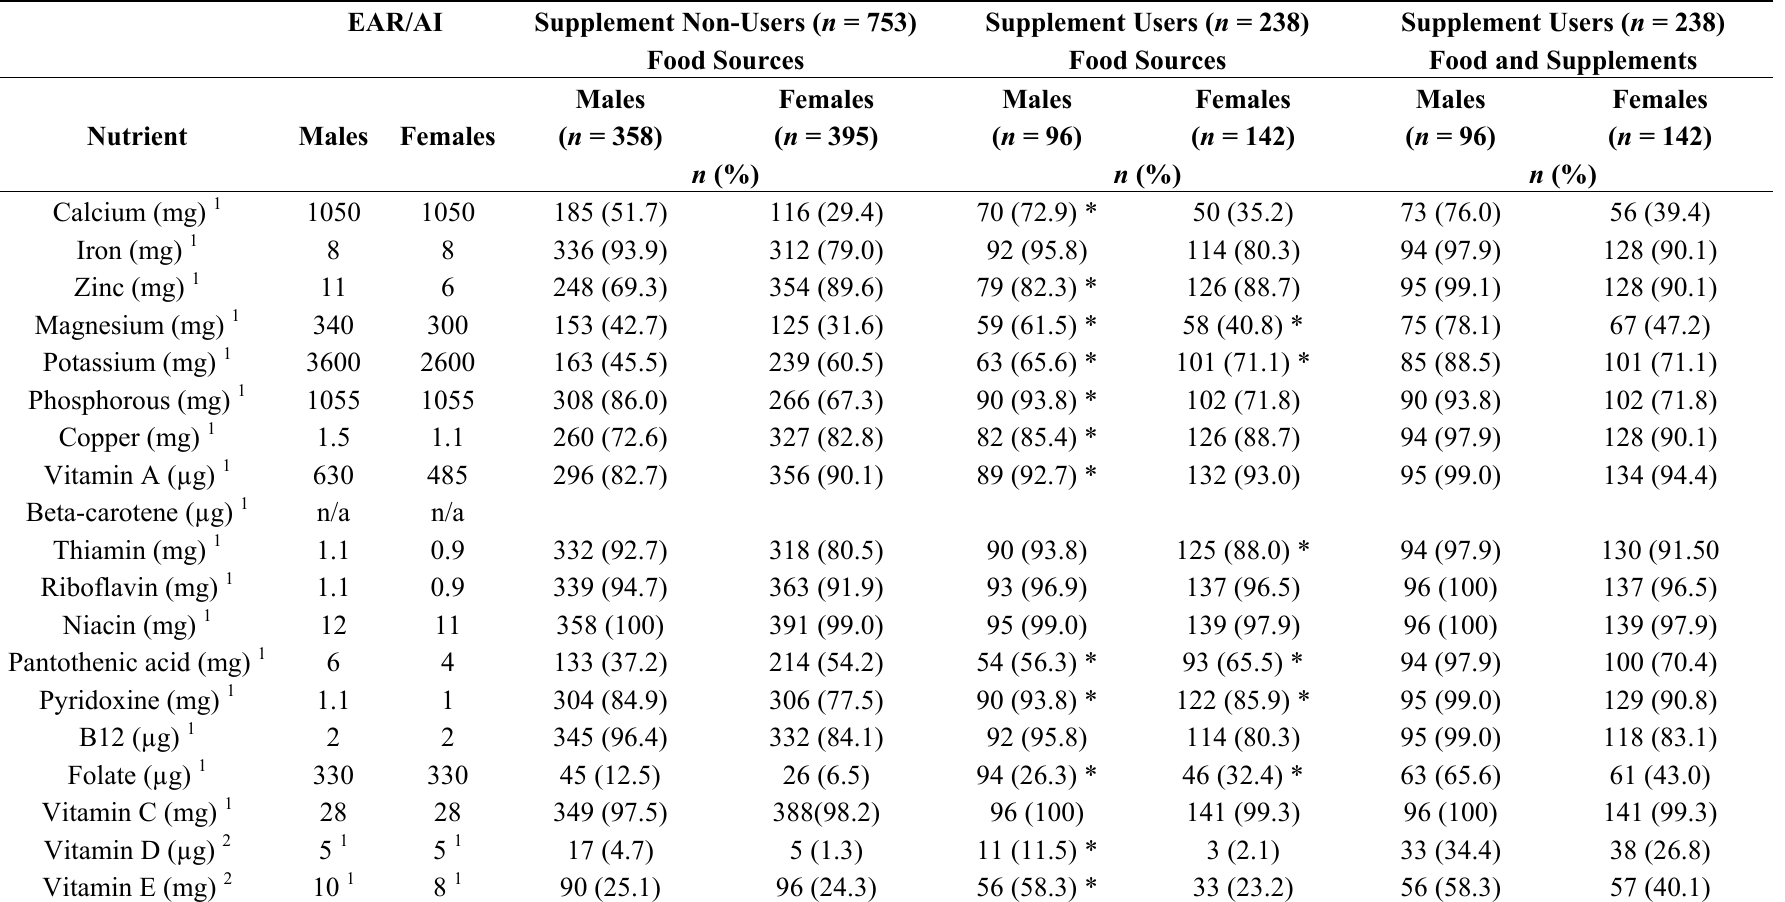
Table 4. Number and percentage [ n (%)] of adolescents meeting the EAR or AI [27] in male and female supplement non-users ( n = 753) and users ( n = 238) in 17 year old adolescents in the Western Australian Pregnancy Cohort (Raine)